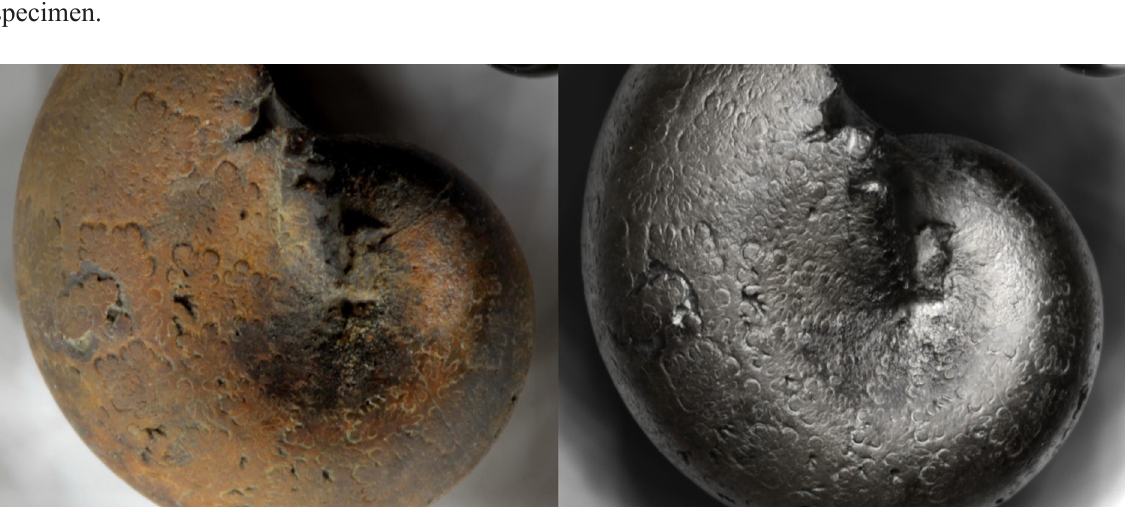
Fig. 2.27. Ammonite lighted with the RTI technique. Left normal view, right specular